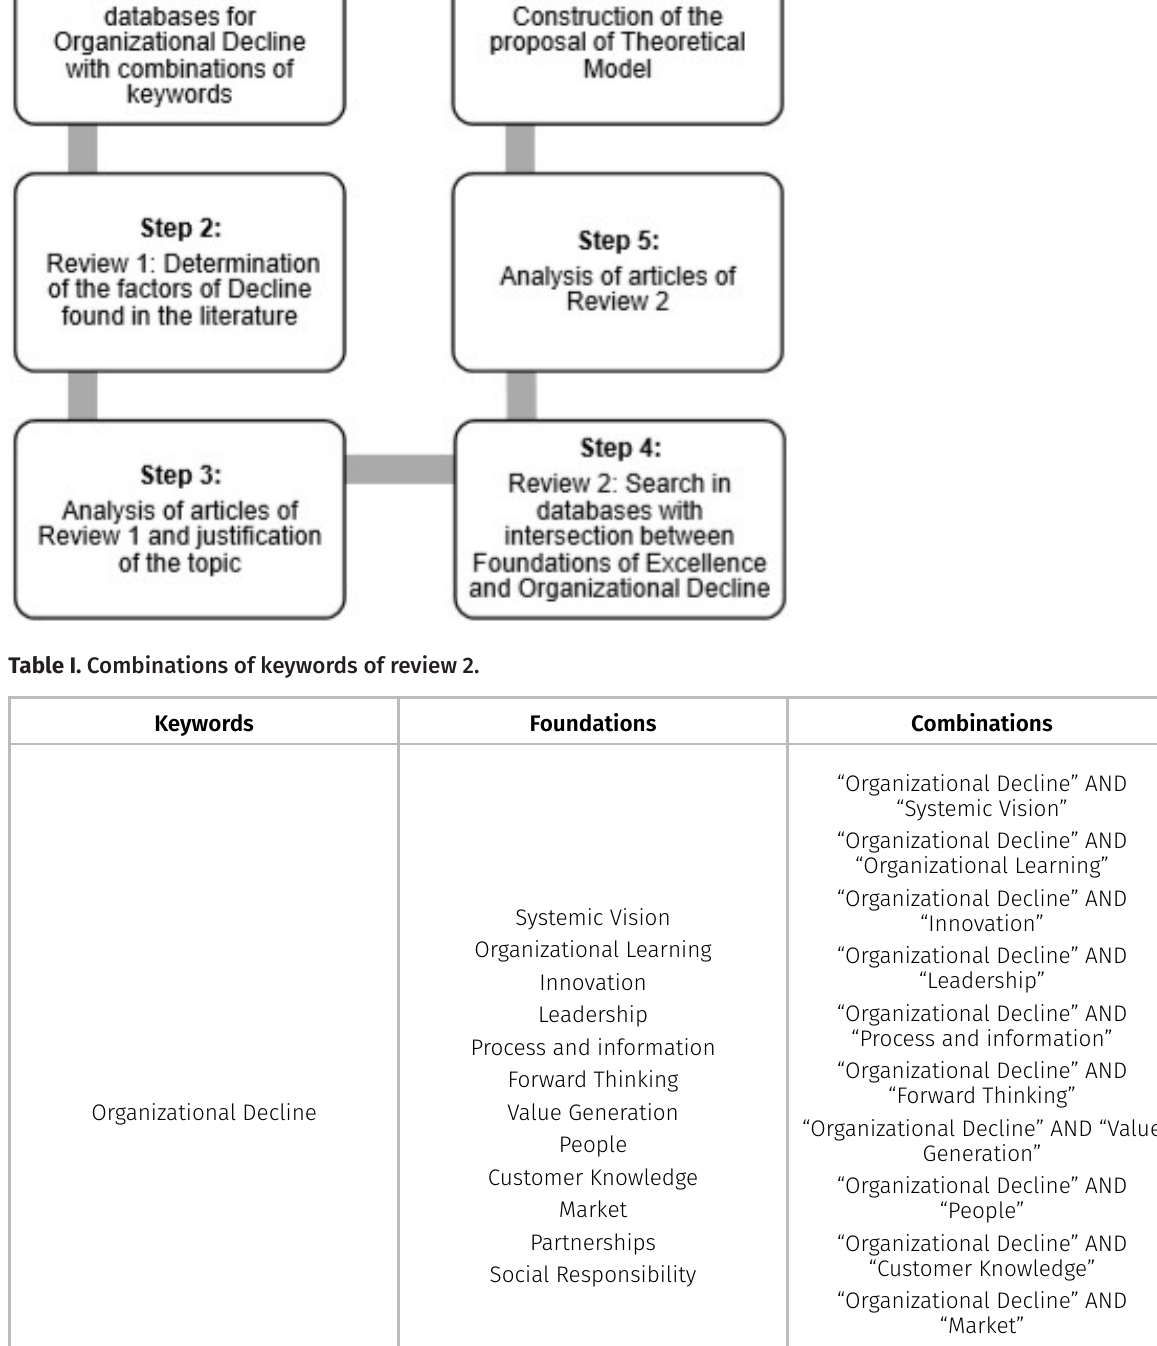
Figure 1. Steps of model